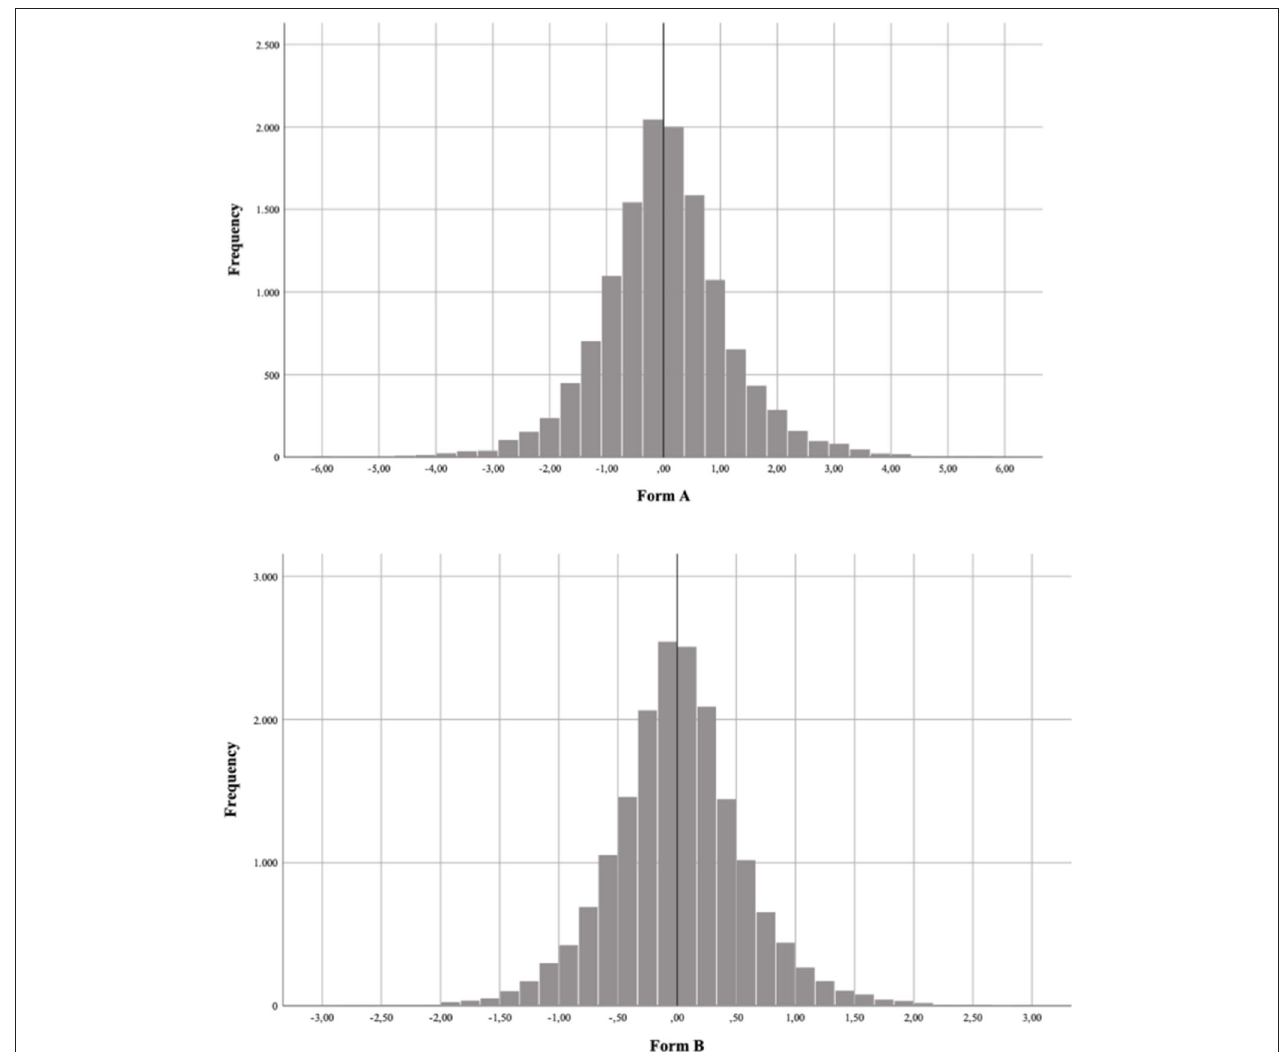
FIGURE 1 | Distribution of the standardized residual (z-scores) for Form A (upper graphic) and Form B (lower graphic).